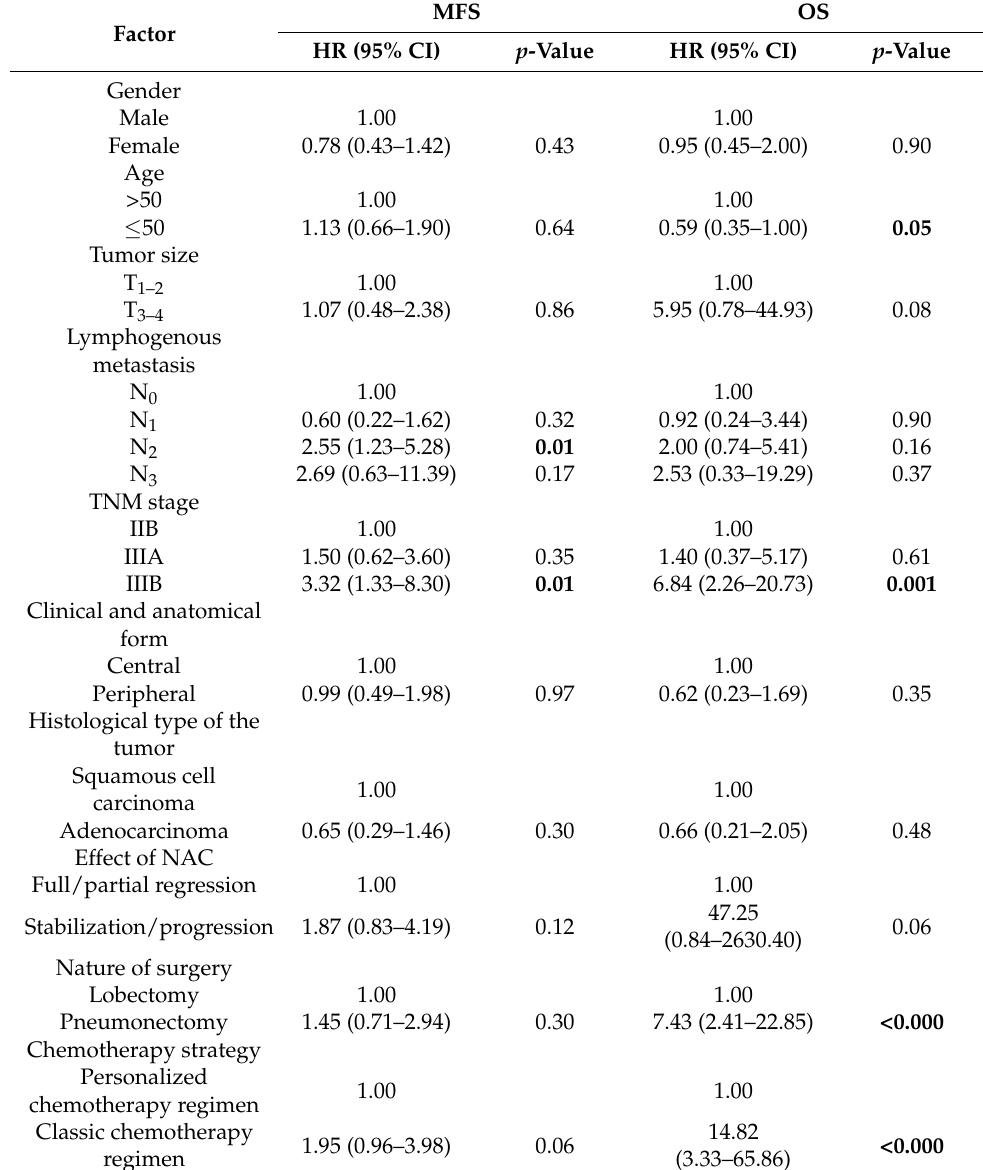
Table 5. Multivariate Cox regression analysis for metastasis-free and overall survival of patients in the study